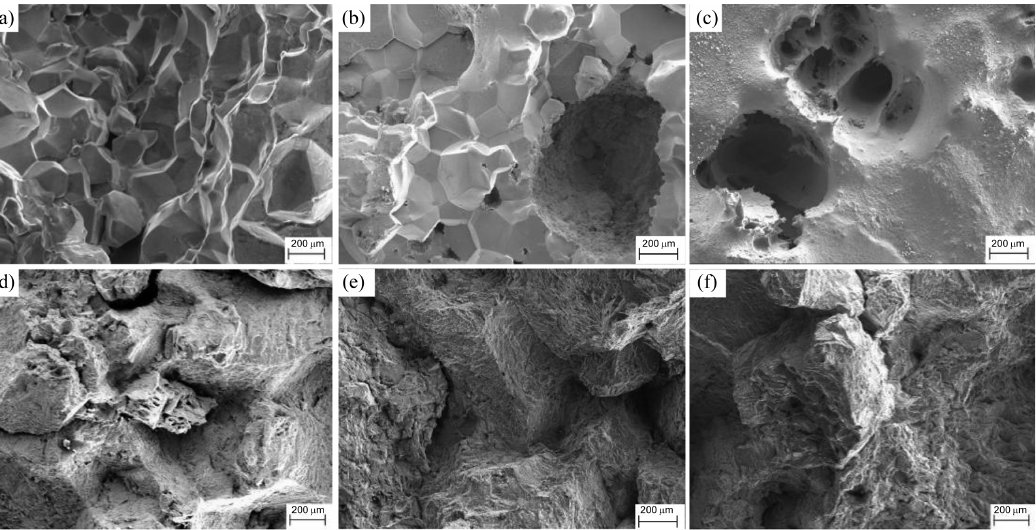
Figure 6: SEM fractographs for the specimens deformed at (a) 1,250°C, (b) 1,100°C, (c) 900°C, (d) 750°C, (e) 700°C and (f) 650°C.